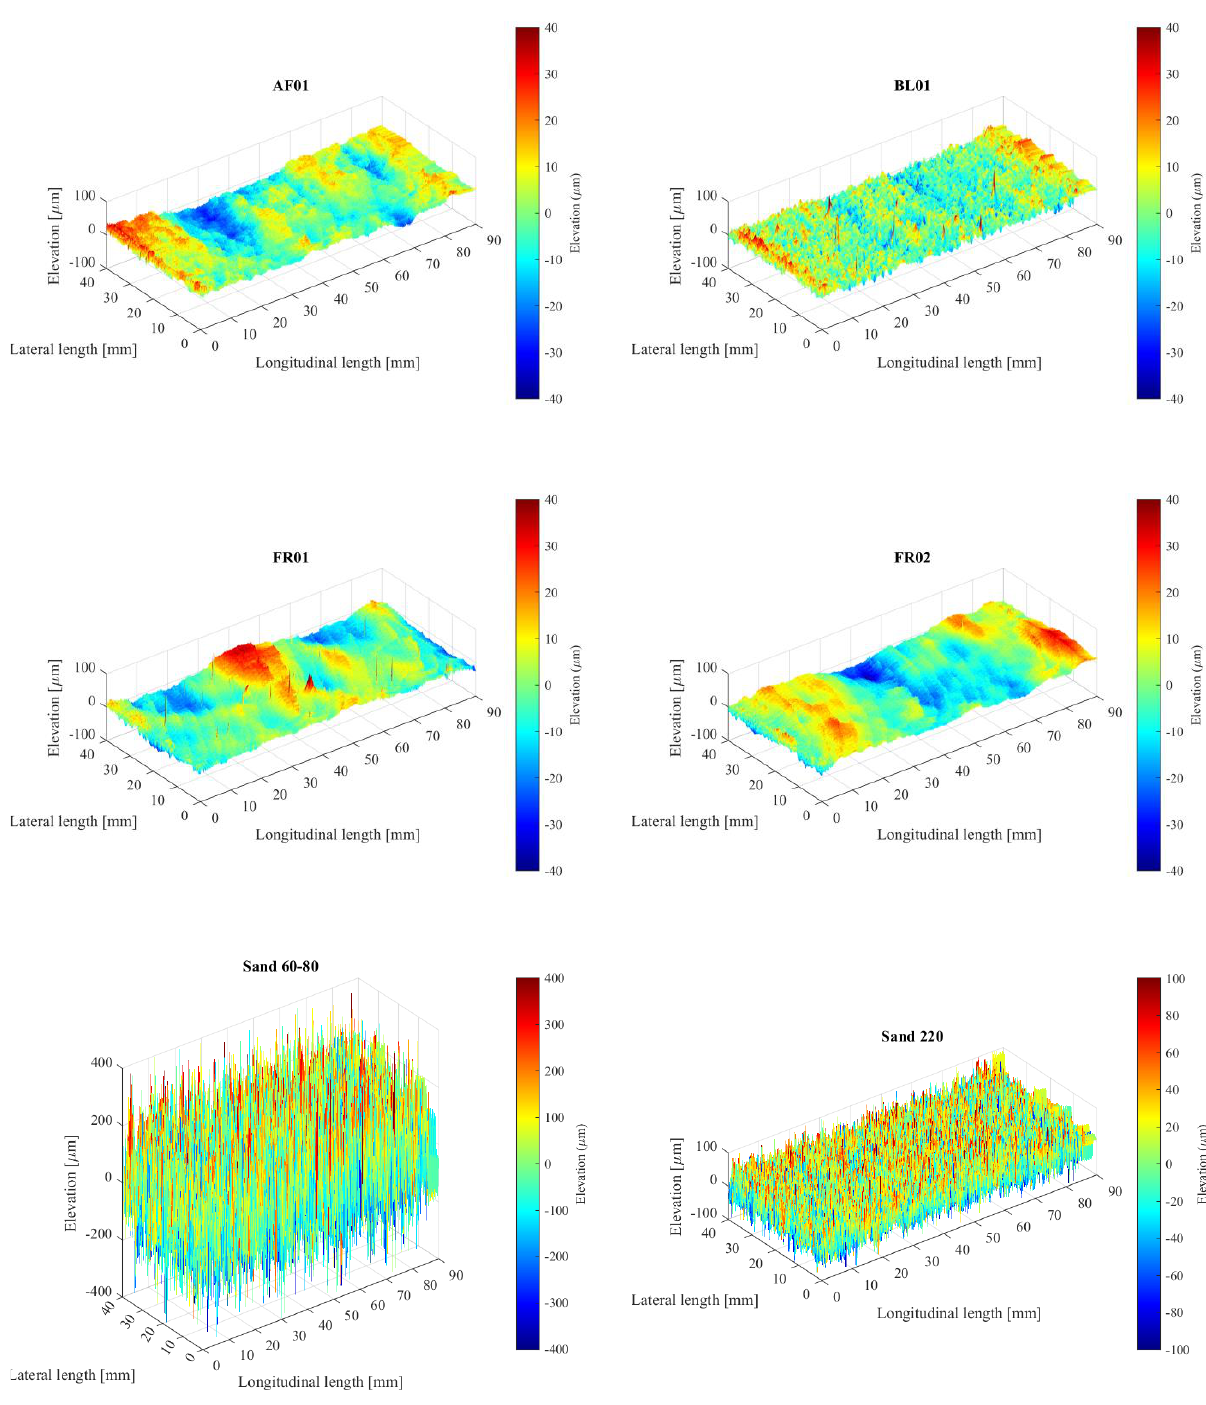
Figure A1. Unfiltered surface topography maps of the test surfaces.